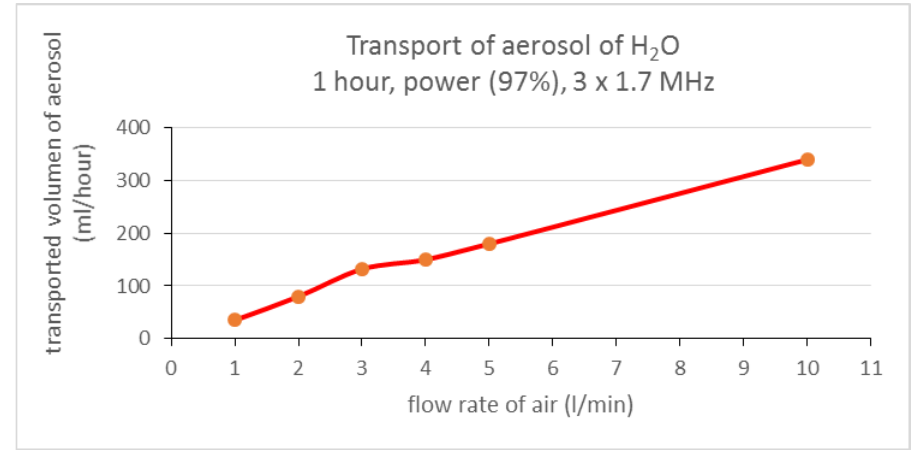
Figure 7 – Transport of aerosol depending on the air flow